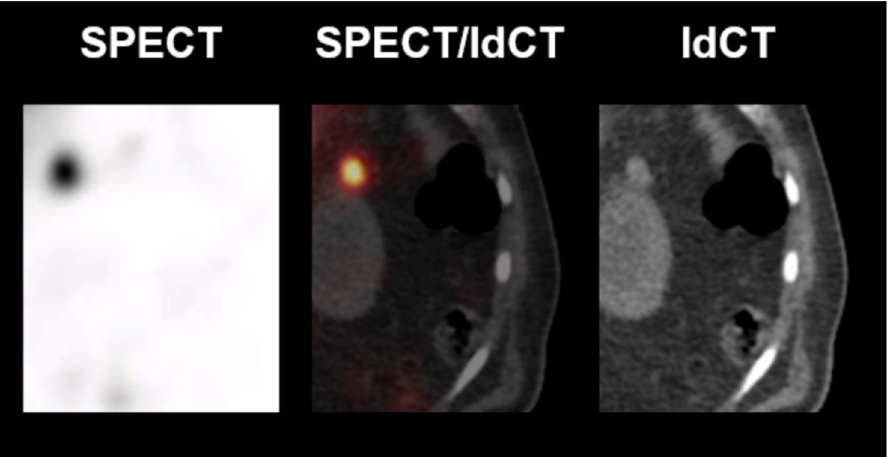
Figure 6. Example of a positive reading in spleen scintigraphy. Left anterior perigastric lesion. ( Left ) 99m Tc-labelled denatured red blood cells SPECT. ( Middle ) 99m Tc-labelled denatured red blood cells SPECT fused to low dose CT. ( Right ) low dose CT.